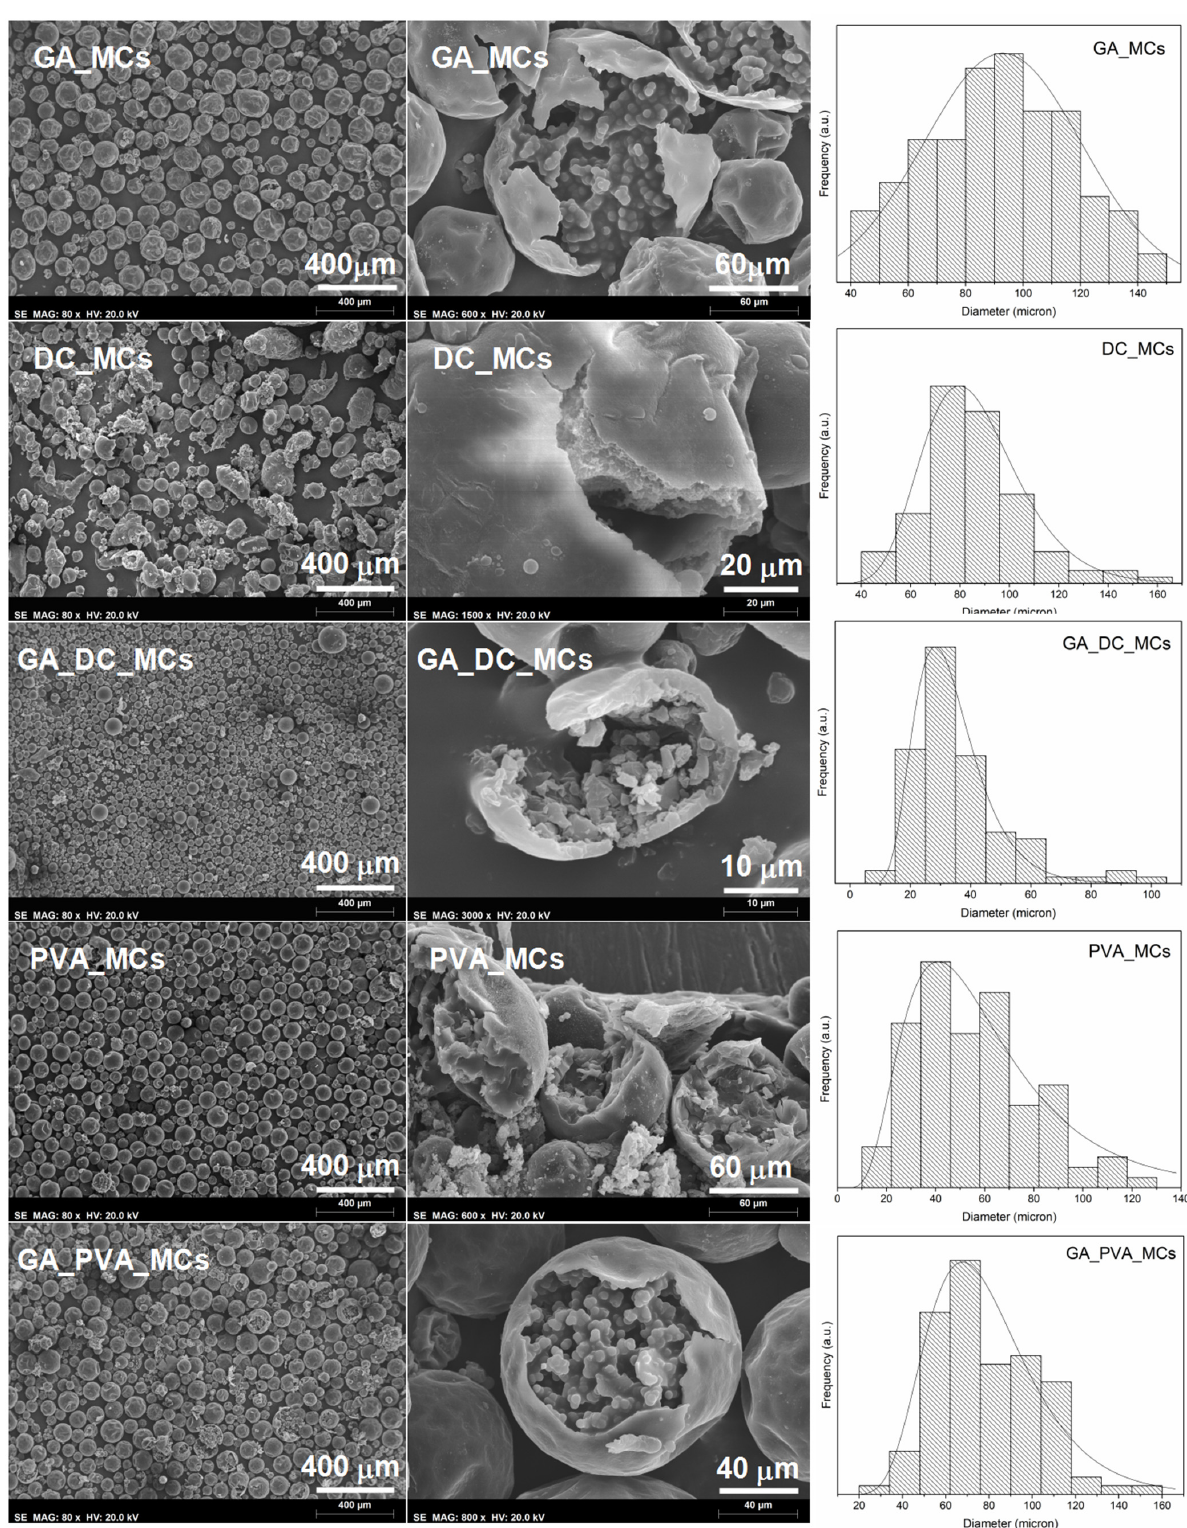
Figure 4. SEM images of the obtained MCs at 80x amplification (at the left). SEM images of isolated MCs’ cross sections, deliberately crushed (obtained at different magnifications). MCs’ size distribution (at the right).